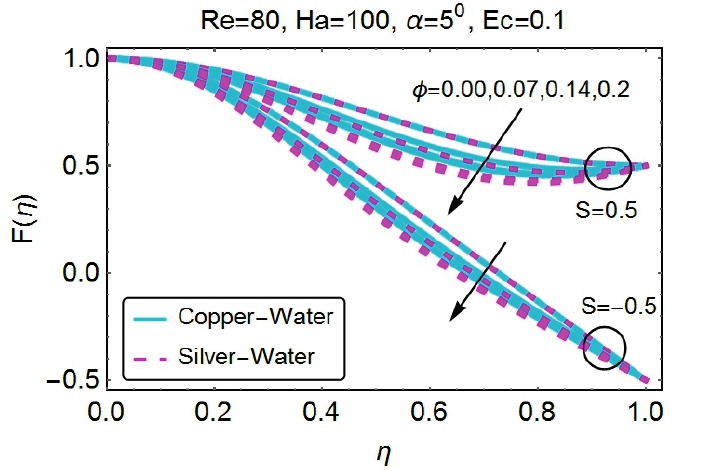
Figure 8. Change in velocity for varying ϕ (divergent channel).